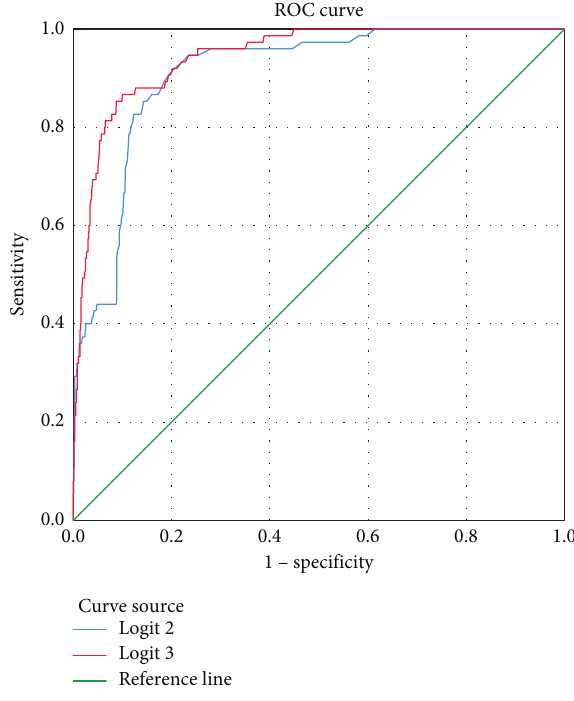
Figure 4: ROC curve analysis of risk factors predicting severe